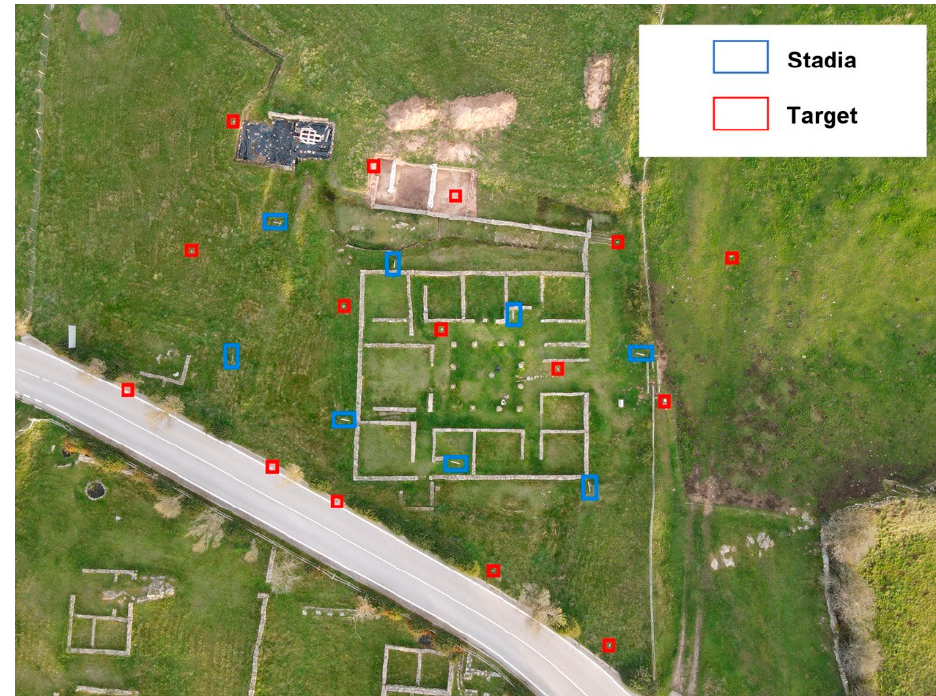
Figure 6. Location of stadias and targets.